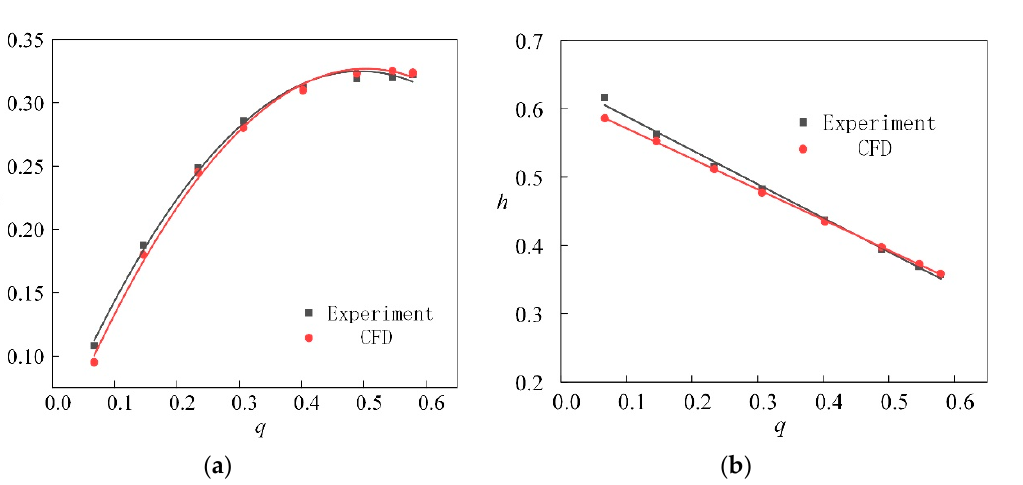
Figure 3. Experiment and simulation data. ( a ) Efficiency; ( b ) head ratio .